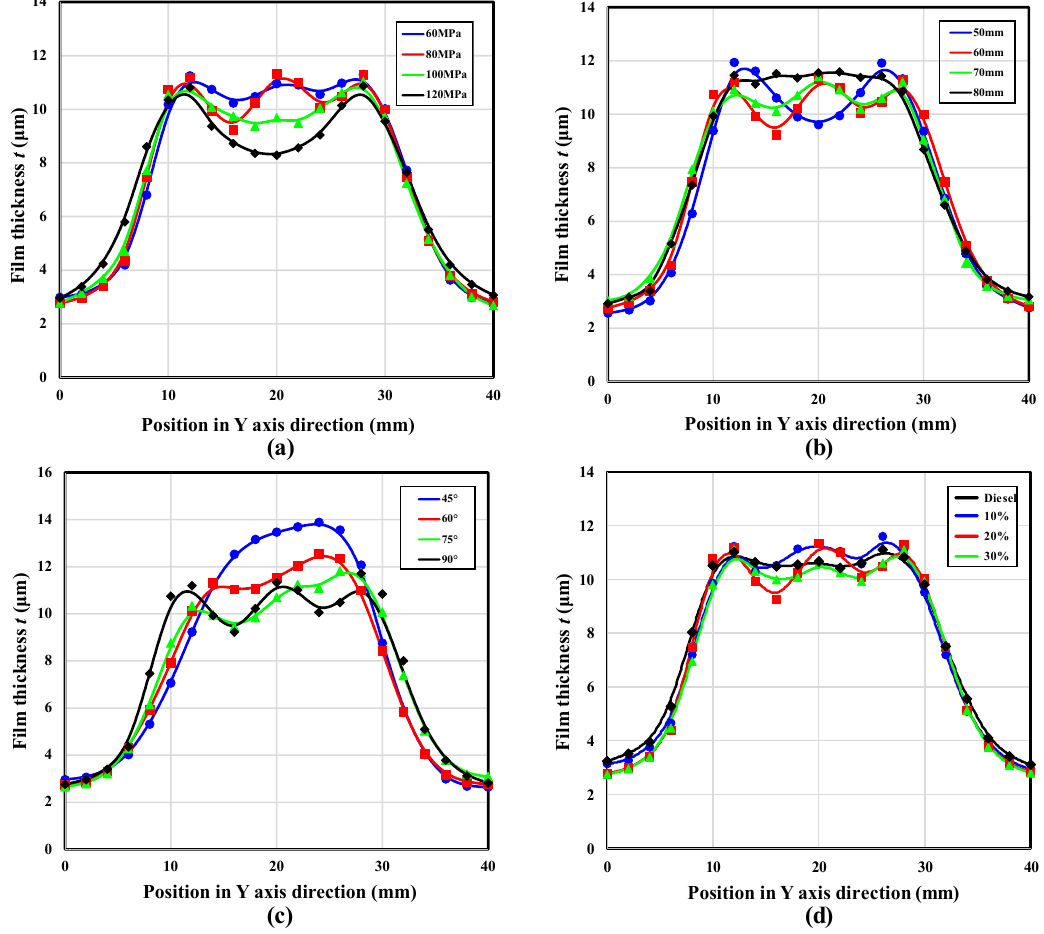
Figure 8. Wall film distributions of different: ( a ) injection pressures; ( b ) impingement distances; ( c ) impingement angles; and ( d ) blending ratios under wet wall conditions.